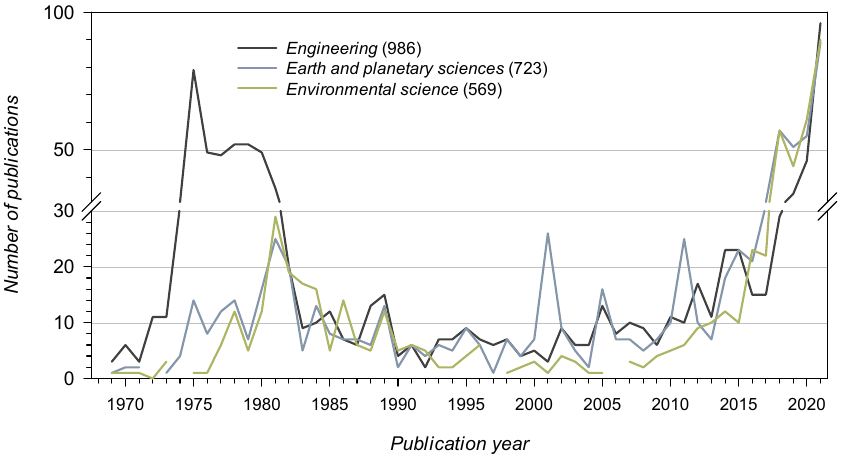
Figure 2. Annual number of publications for the top three subject areas from 1968 to 2021. Note the break in the y-axis.